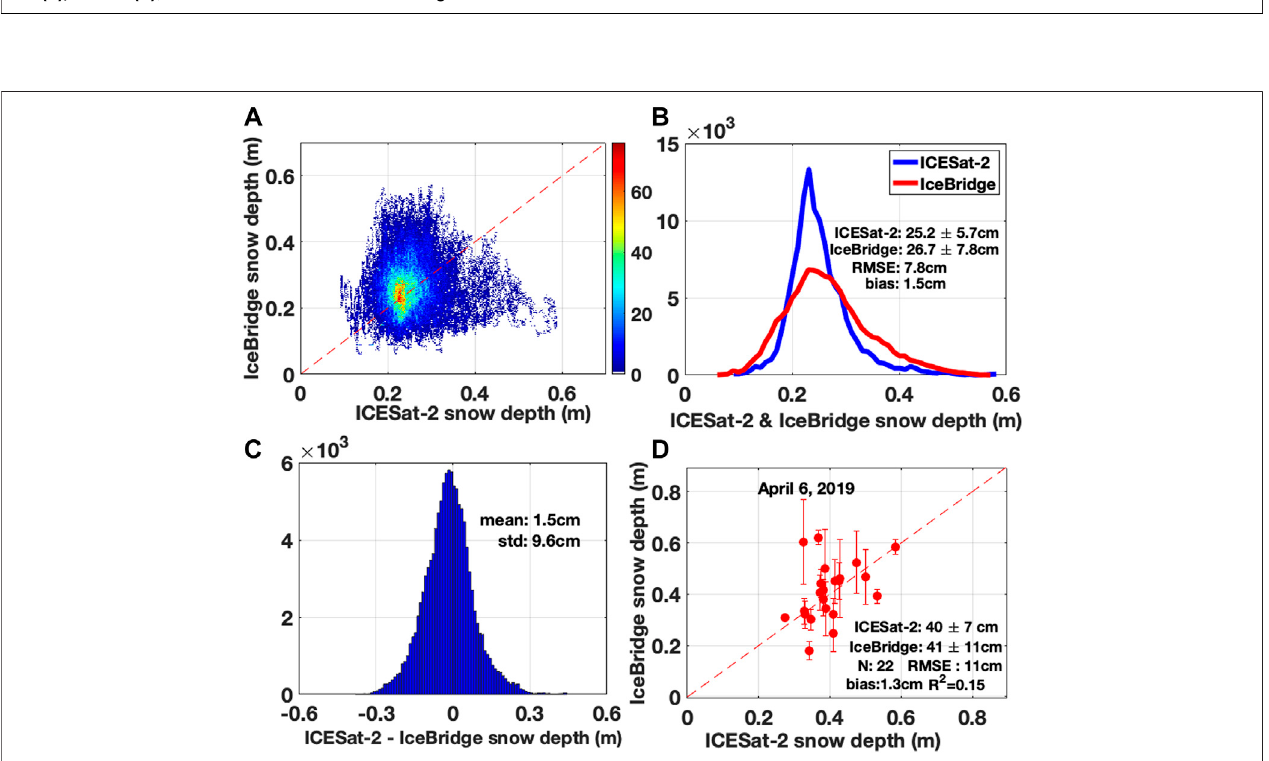
FIGURE 5 | (A) Comparison of snow depth: ICESat-2 ( x -axis) versus co-located IceBridge snow radar ( y -axis). Co-location is found when the footprints distances between two instruments are less than 4 km. The color bar represents the number of co-located observations. (B) Histogram of ICESat-2 and IceBridge snow depth distributions. (C) Histogram showing the snow depth differences between ICESat-2 and IceBridge. (D) Scatter plots between ICESat-2 and IceBridge snow depths at the crossovers on 6 April 2019 (see Figure 3 ), where the distances between the two instruments are less than 15 m.